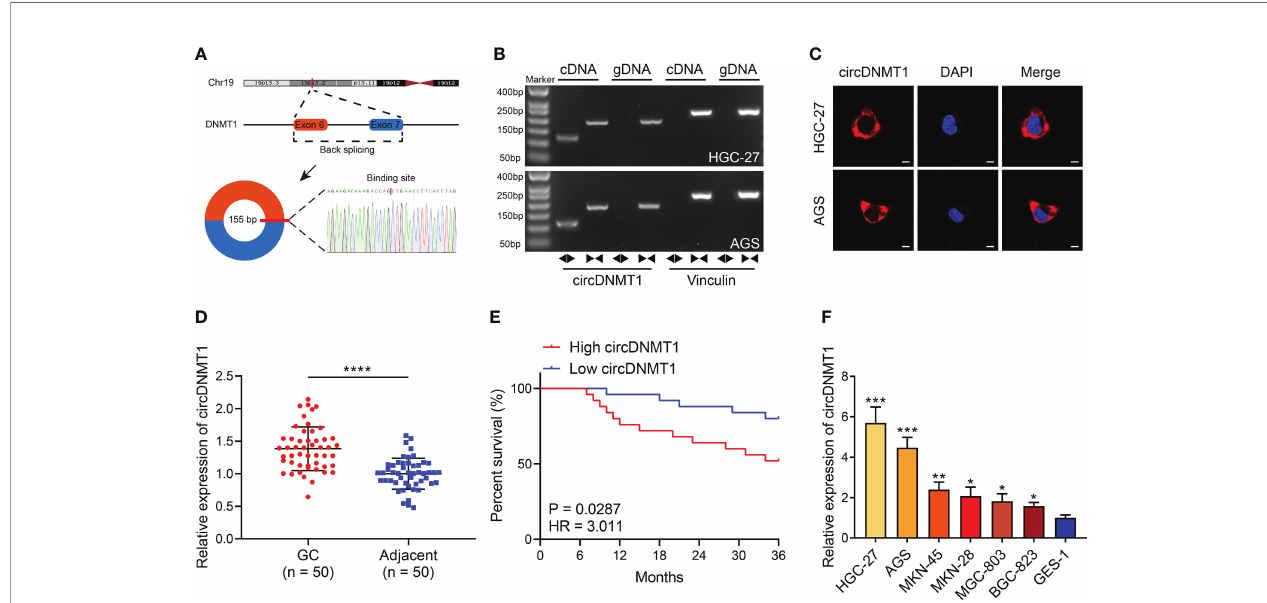
FIGURE 1 | Identi fi cation of circDNMT1 characteristics in GC. (A) The schematic illustration of circDNMT1 origination and the result of Sanger sequencing. (B) The gel electrophoresis to examine ampli fi ed product of qRT-PCR using convergent and divergent primers. (C) FISH to display the distributions of cricDNMT1 in HGC-27 and AGS cells. Scale bar: 10 m m. (D) The qRT-PCR analysis to show circDNMT1 expression in 50 pairs of GC and adjacent normal tissues. (E) The Kaplan-Meier plot to show survival time of 50 GC patients who were divided into high-circDNMT1 and low-circDNMT1 groups. (F) The qRT-PCR analysis to show circDNMT1 expression in HGC-27, AGS, MKN-45, MKN-28, MGC-803, BGC-823 and GES-1 cell lines. Data were presented as means ± SD. *P < 0.05, **P < 0.01; ***P < 0.001, ****P < 0.0001.